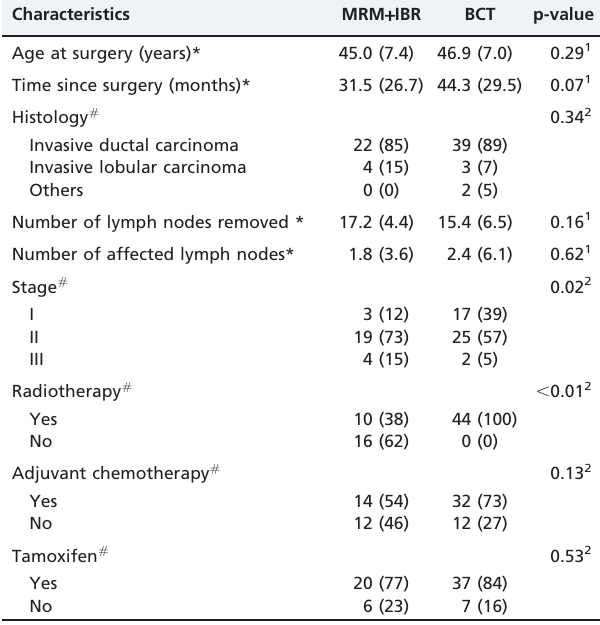
Table 3 - Disease and treatment-related features of women with breast cancer submitted to MRM + IBR (n = 26) or BCT (n= 44).